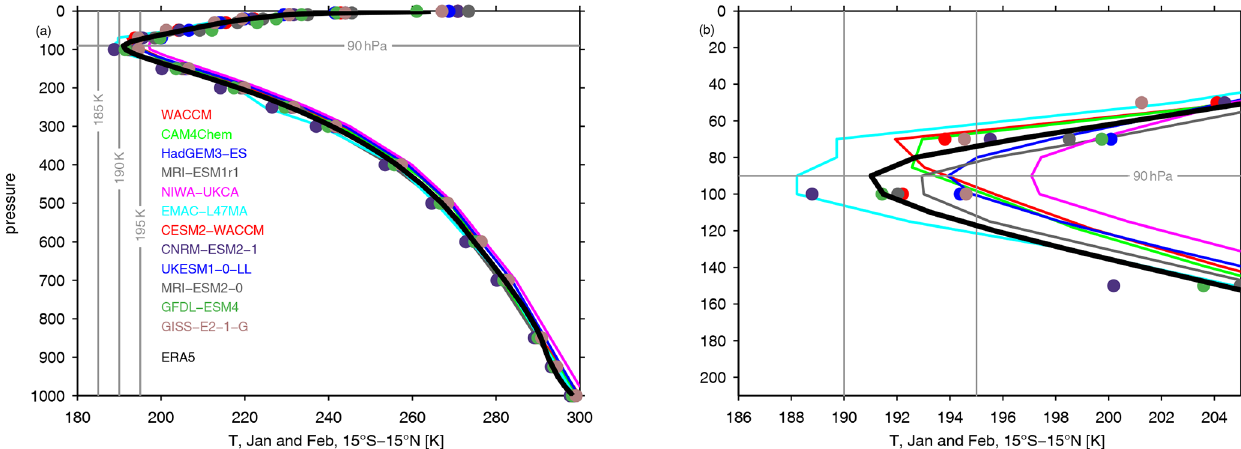
Figure 8. Climatological mean temperature in January and February from 10 ◦ S to 10 ◦ N for each model and model level data from ERA5.1. Panel (b) enlarges the cold-point region from panel (a) . For CMIP6 models, we only show the 100 and 70hPa levels due to the limited resolution available in the CMIP data